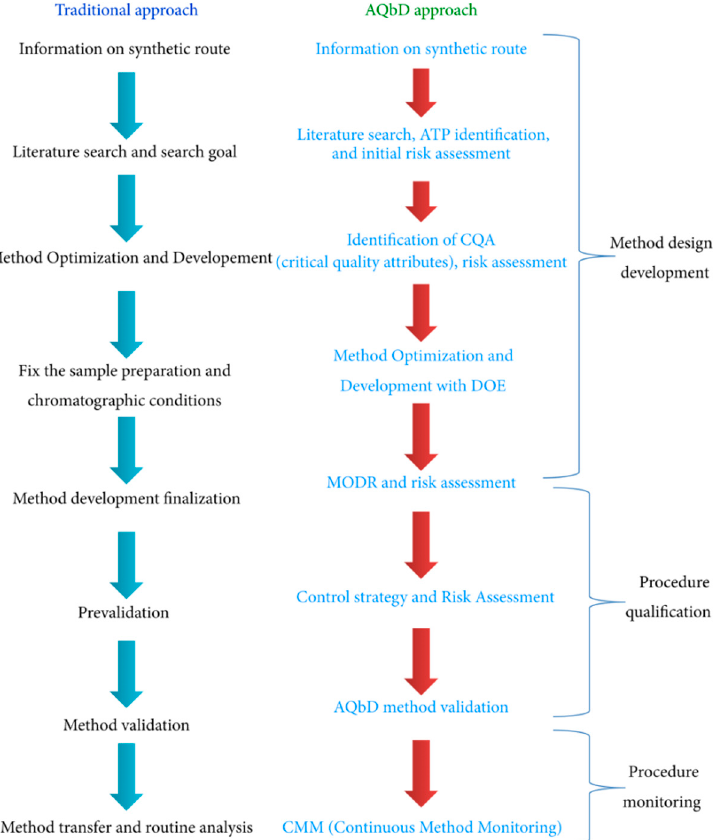
Figure 5. Traditional and AQbD approaches for Analytical Method Development. Reprinted with permission from Raman, N. et al. Journal of Chemistry , 2015. Copyright (2015) Hindawi